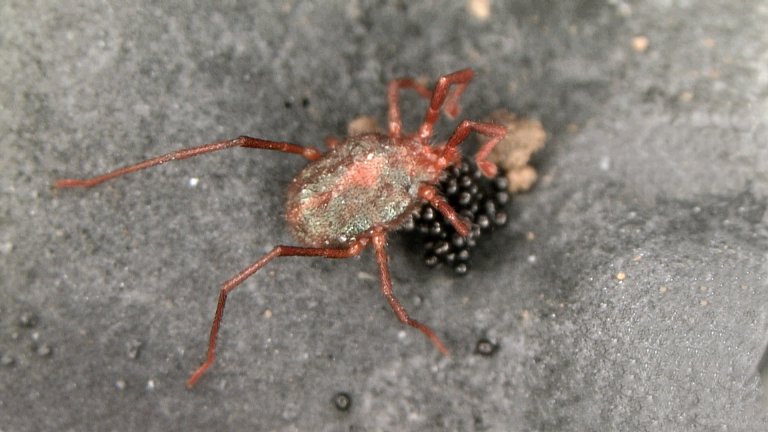
Erythraeus
regalis. Photo Joanna Mąkol.